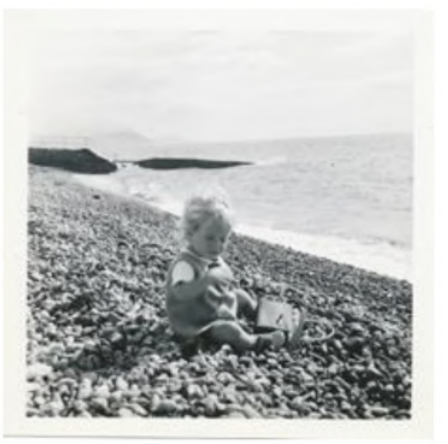
Figure 12. Author